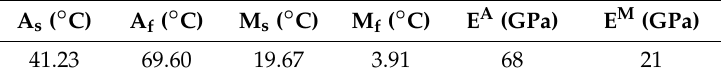
Table 1. Ni 52 Ti 48 mechanical properties [134].